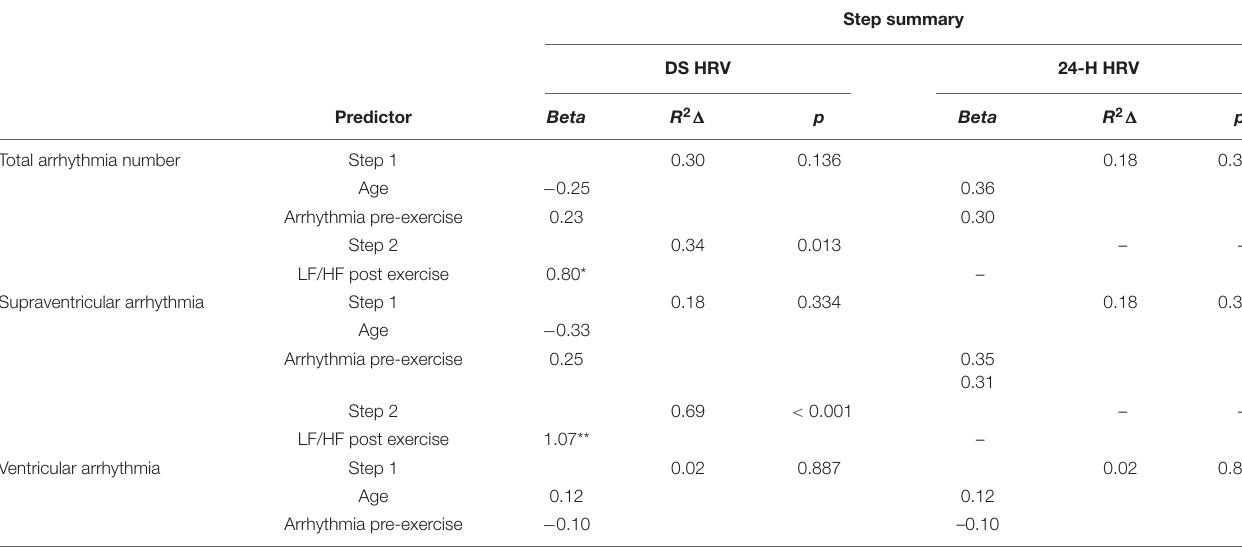
TABLE 4 | Hierarchical regression with a Stepwise solution after step 1 assessing if measures of 24-h and deep sleep HRV are associated with post exercise ECG abnormality and arrhythmia after controlling for age and pre-exercise abnormality ( n =